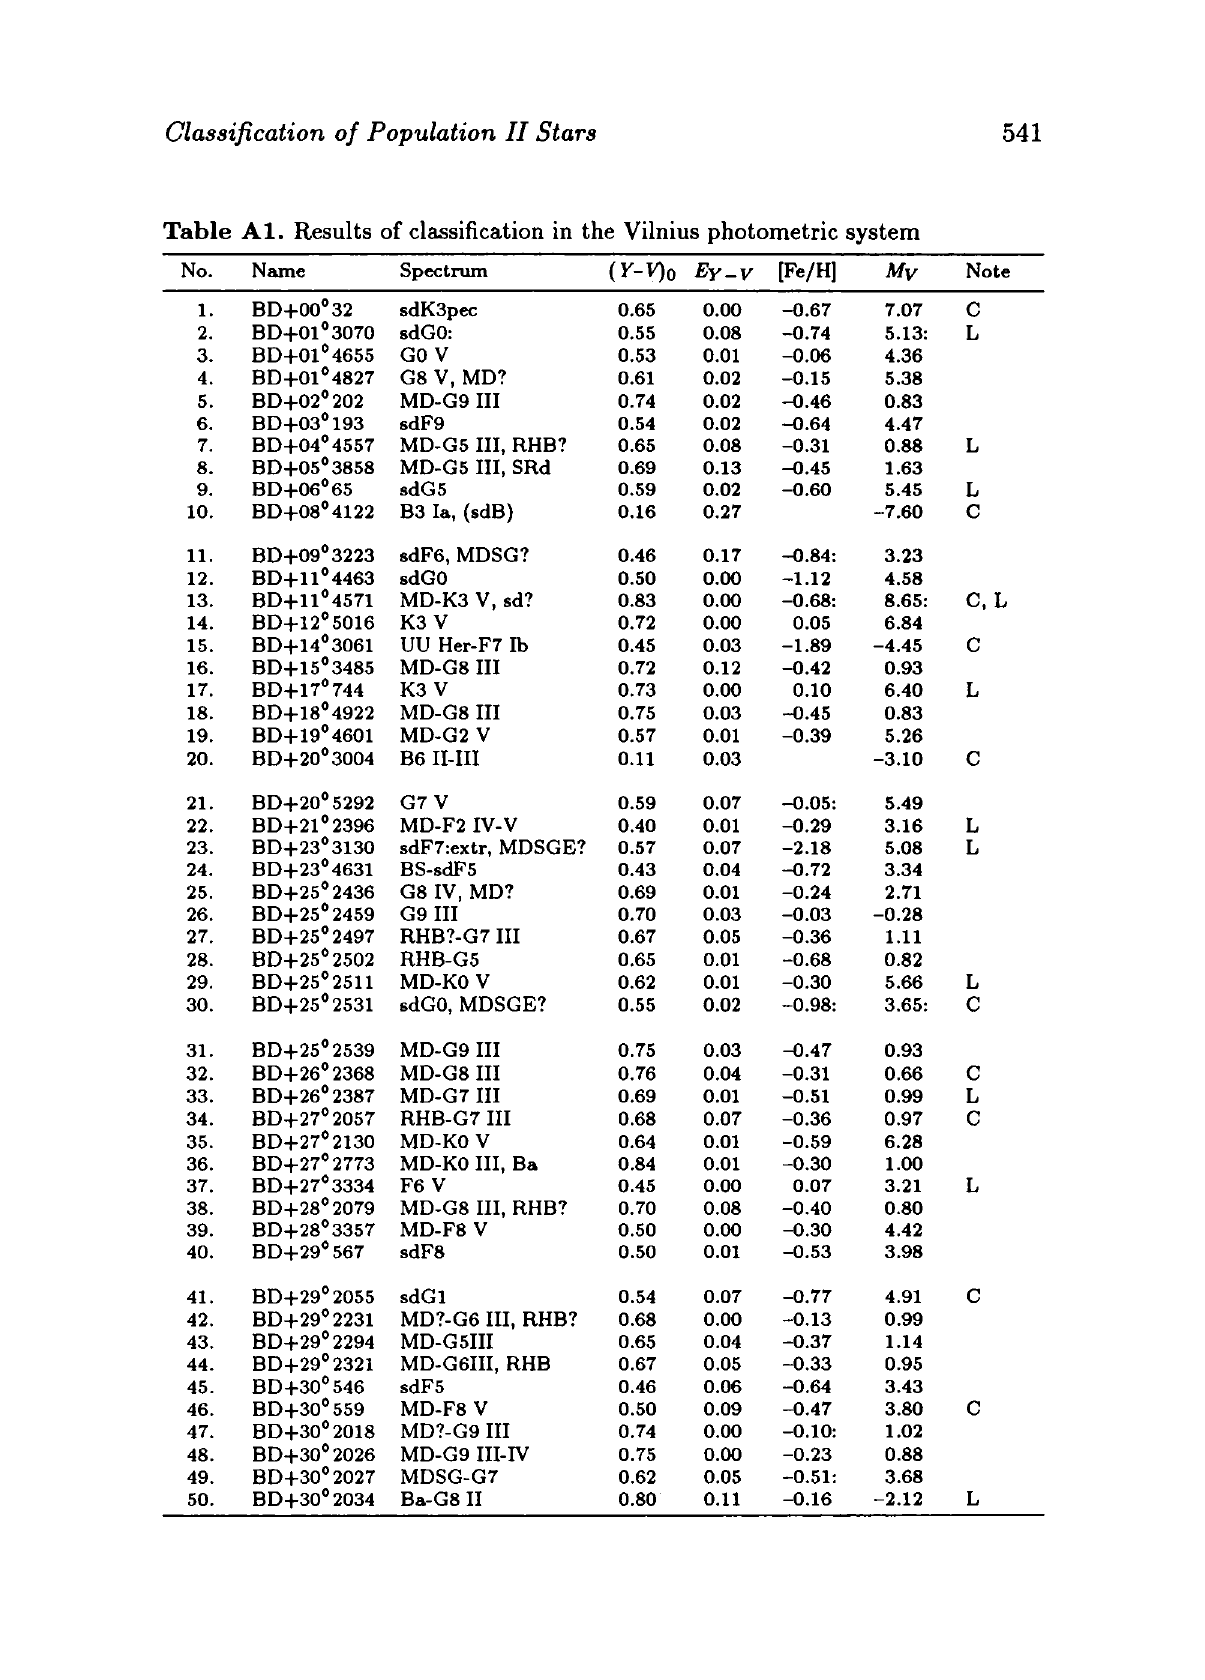
Table A l. Results of classification in the Vilnius photometric